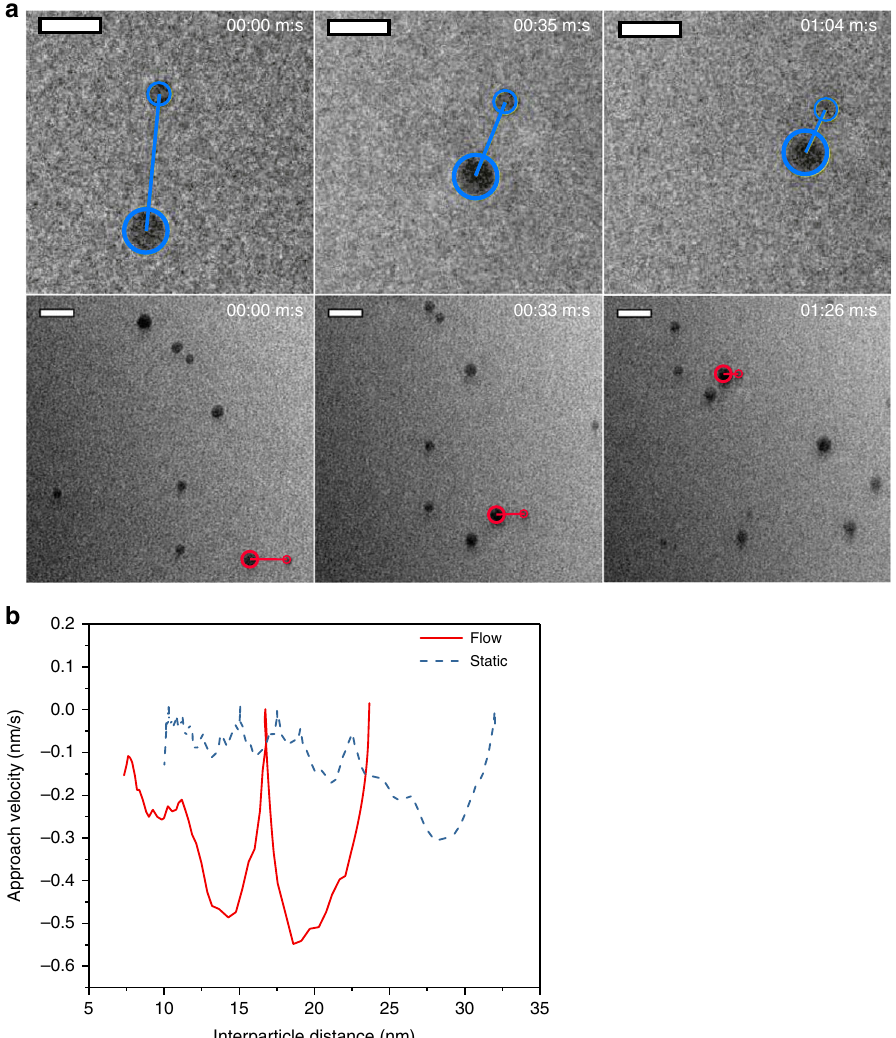
Fig. 5 Attachment of particles in static and fl owing conditions. a At top are particles aggregating in static liquid (scale bar = 10 nm) and at bottom are particles aggregating in bubble-driven fl ow (scale bar = 20 nm). Particles of interest and their interparticle distance are outlined. b The approach velocity plotted against interparticle distance in fl ow and static fl uids, indicating accelerated aggregation in fl